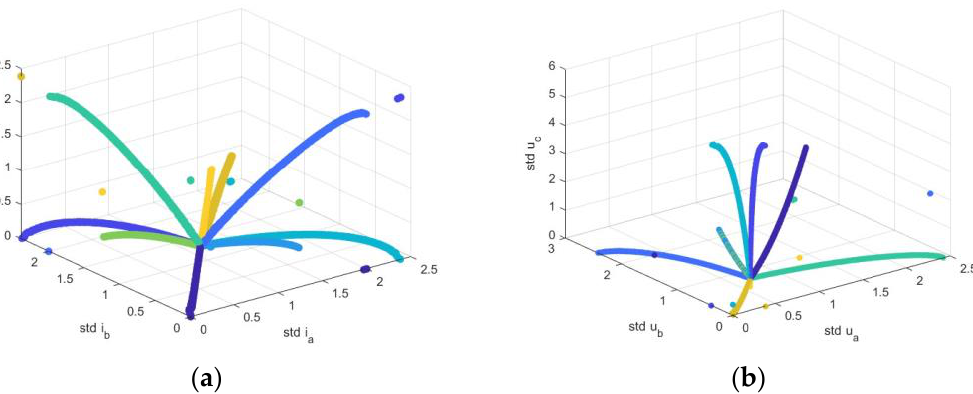
Figure 10. Dependence of the root-mean-square deviations of the ( a ) currents 𝑖 𝑎 , 𝑖 𝑏 , 𝑖 𝑐 and ( b ) voltages 𝑢 𝑎 , 𝑢 𝑏 , 𝑢 𝑐 .